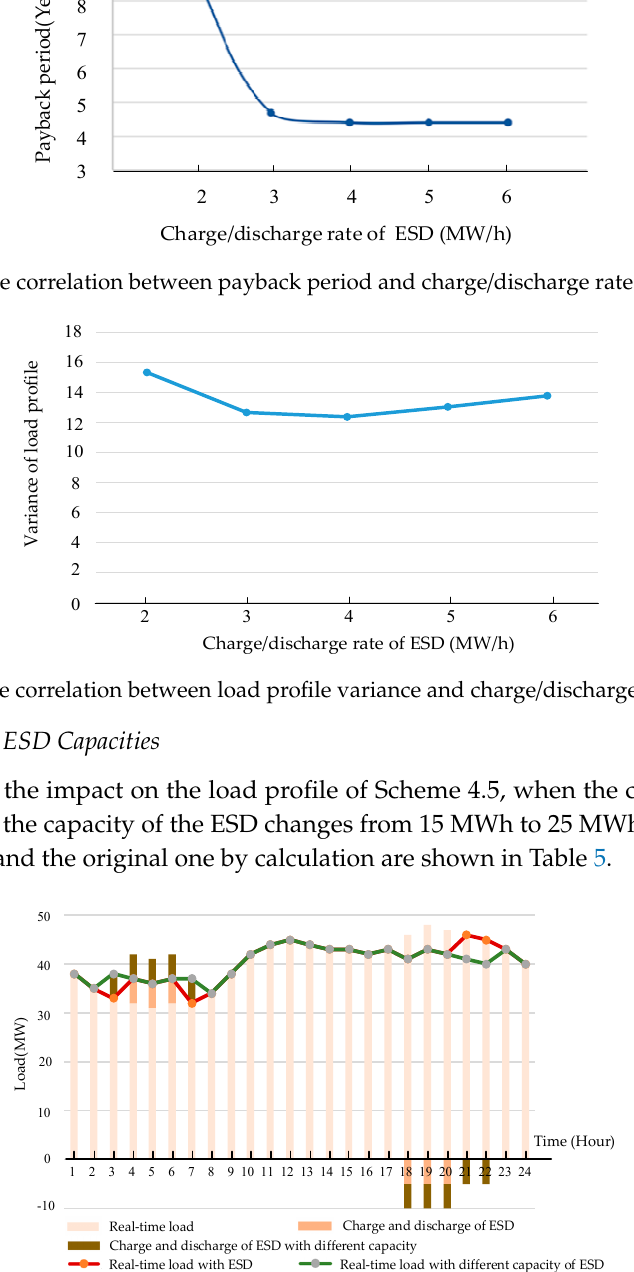
Figure 11. Comparison of load profile of Scheme 4.5 with the original scheme. Table 5. Comparison of parameters of Scheme 4.5 with the original scheme.